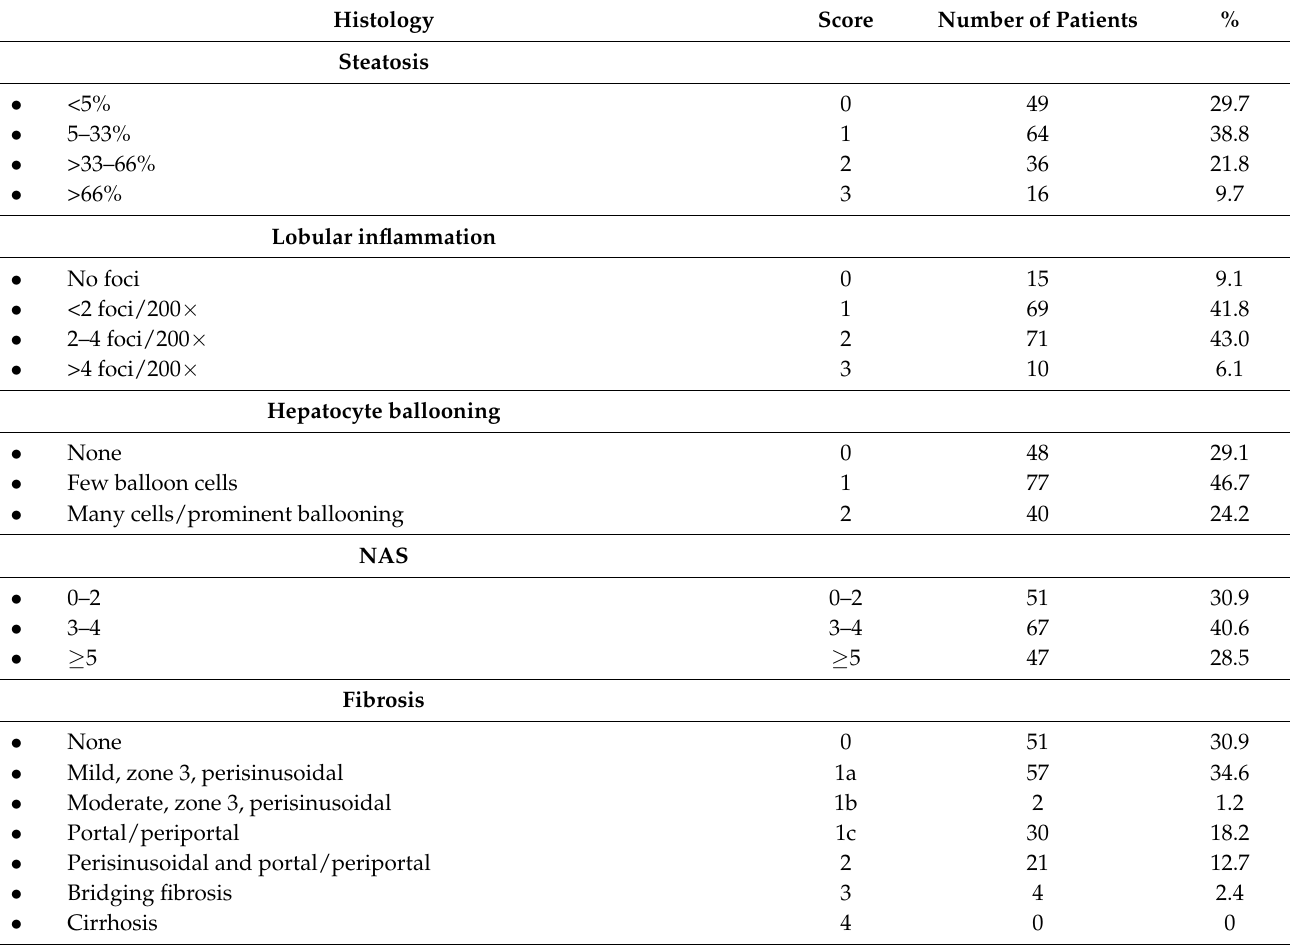
Table 2. Results of liver biopsies in 165 patients undergoing bariatric surgery.